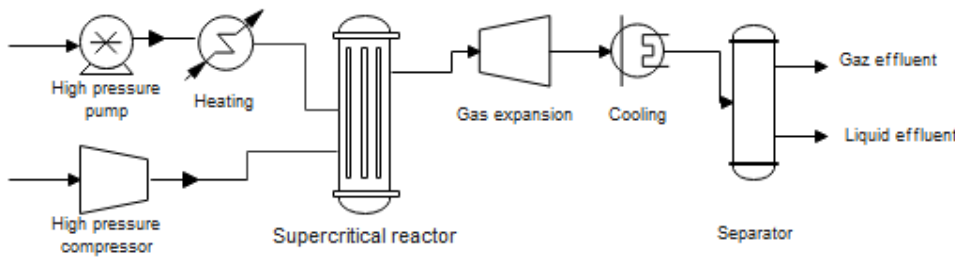
Figure 5. Schematic diagram of the SCWO (drawn using Superpro Designer software).